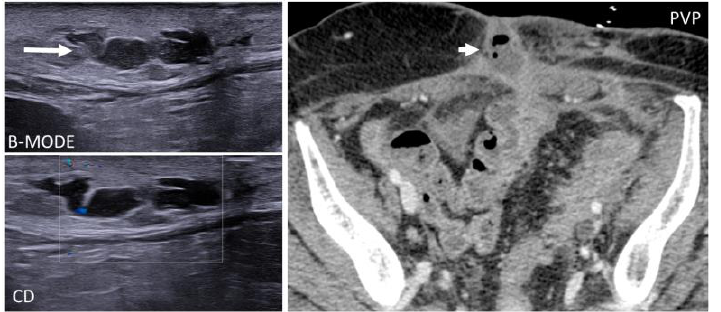
Figure 1. Abscesses on US and CT in a 69-year-old woman with myelofibrosis, presenting with pain along the surgical scar and persistent fever two weeks after splenectomy. B-mode US (first